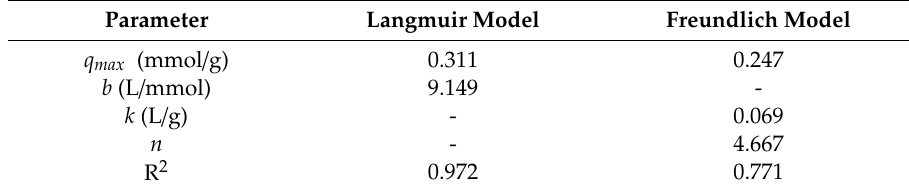
Table 4. Fitting of adsorption parameters used in Langmuir and Freundlich models.